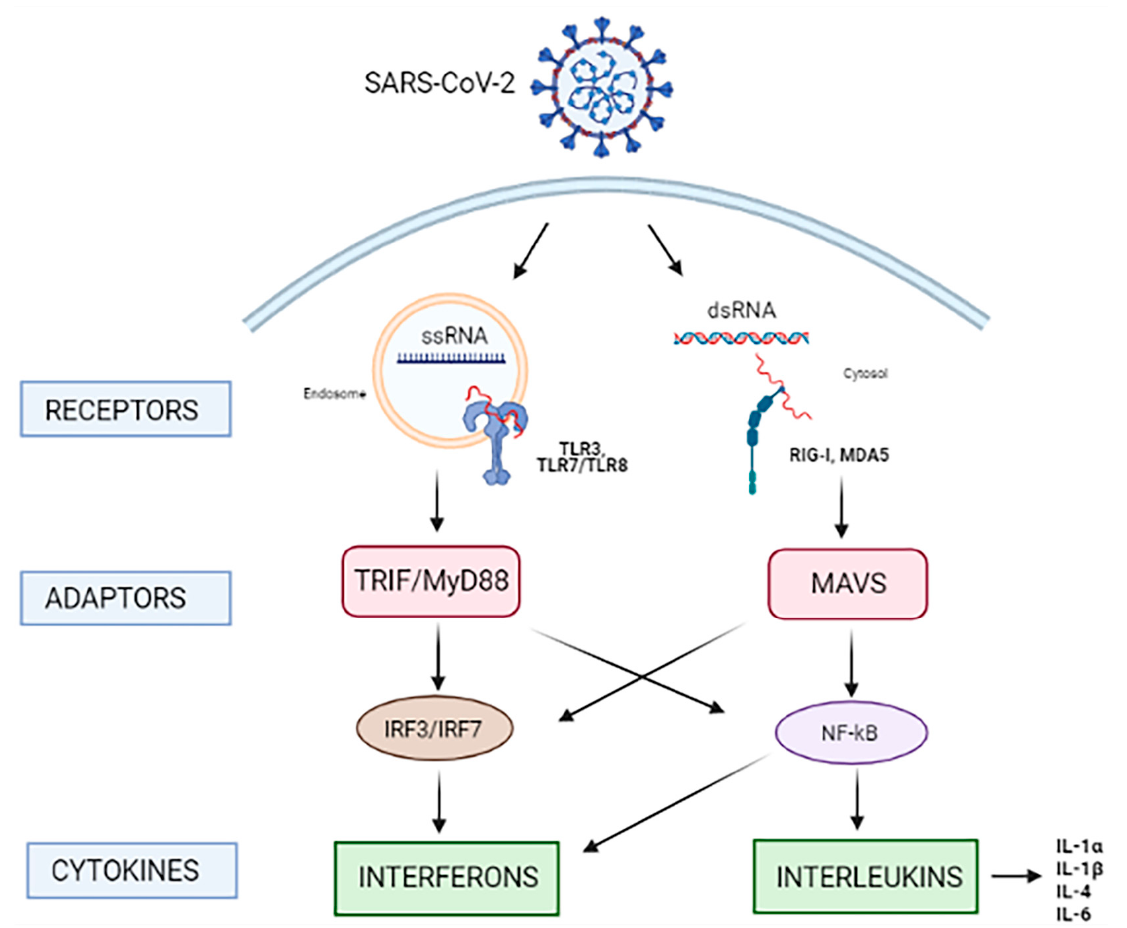
Figure 2. SARS-CoV-2 RNA sensing. After host cells viral infection, SARS-CoV-2 genome is sensed by endosomal Toll-like receptors (TLRs) TLR3, TLR7 and TLR8. TLRs recruit adaptor proteins TIR-domain-containing adapter-inducing interferon- β (TRIF) and myeloid differentiation factor 88 (MyD88). The sensing of replicating virus also occurs by cytosolic RIG-I-like receptors (RLRs) retinoic acid inducible gene I (RIG-I) and melanoma differentiation associated protein (MDA5), that recognize the subgenomic dsRNA of SARS-CoV-2. RIG-I and MDA5 recruit the mitochondrial antiviral signaling protein (MAVS). TLRs and RLRs signaling activate downstream transcription factors, including interferon regulatory factor 3 and 7 (IRF3 and IRF7) and nuclear factor kappa light-chain-enhancer of activated B cells (NF- κ B), resulting in production of antiviral interferons and different chemokines (IL-1 α , IL-1 β , IL-4 e IL-6), which in turn leads to the IRF-3 and IRF-7 phosphorylation required for the expression of